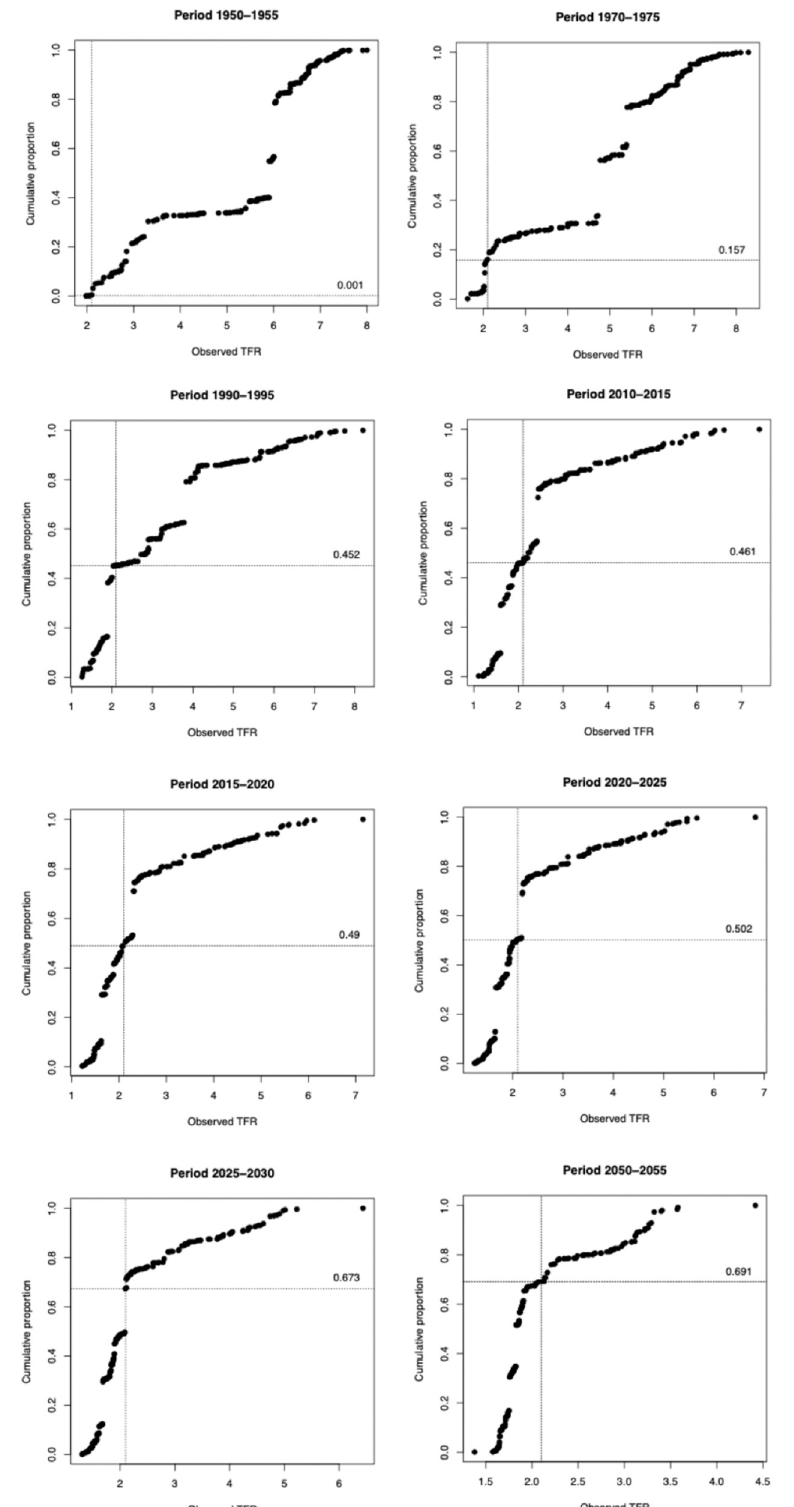
Fig 1. Cumulative proportion of global population (y-axis) of UN-specified territories ordered by observed TFR (x- axis) with proportion living in territories where observed TFR is equal or less than 2.1 (intersecting line), selected